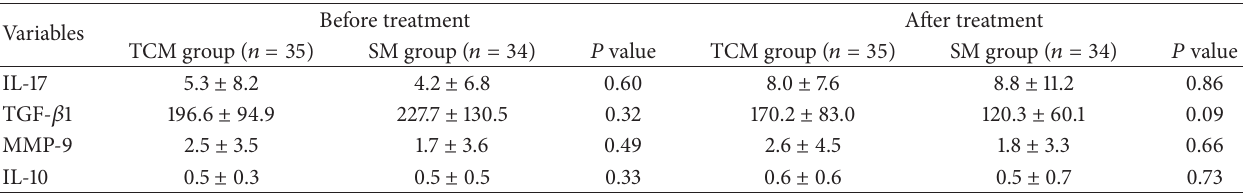
Table 2: Comparison of the mRNA expression levels of IL-10, IL-17, TGF- 𝛽 1, and MMP-9 between the TCM and SM groups before and after treatment (mean ± SD).